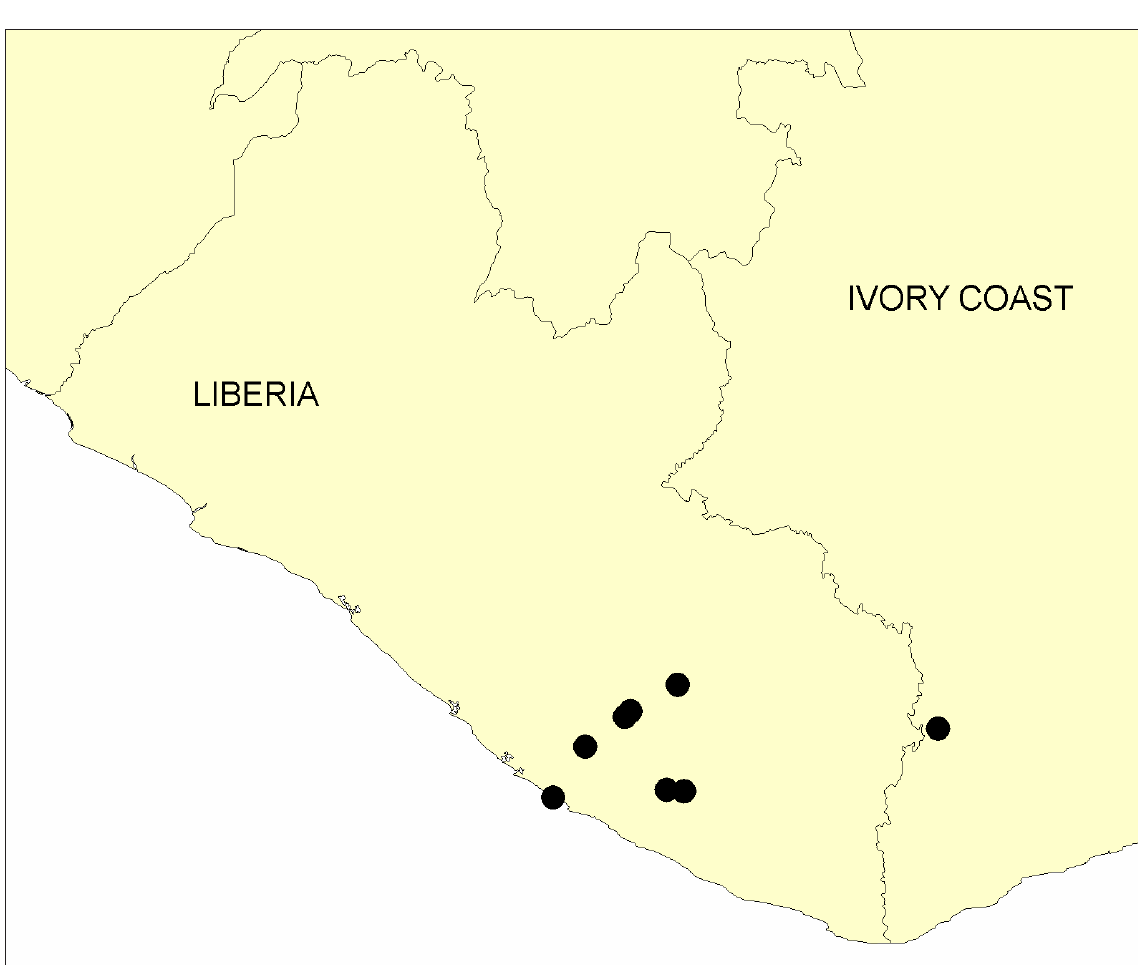
Fig. 4. Distribution map of Rhaphiosylis minima sp. nov